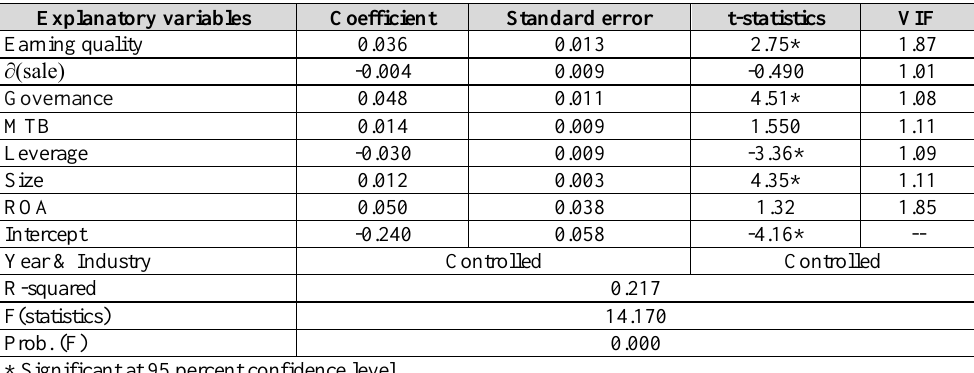
Table 2. H1 test